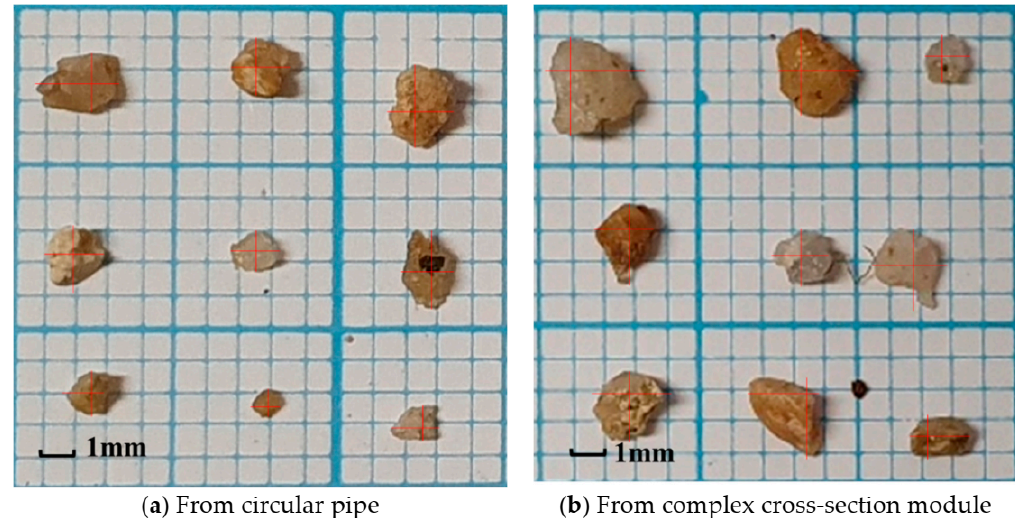
Figure 9. Largest sand grains being transported from circular pipe ( a ) and complex cross-section module ( b